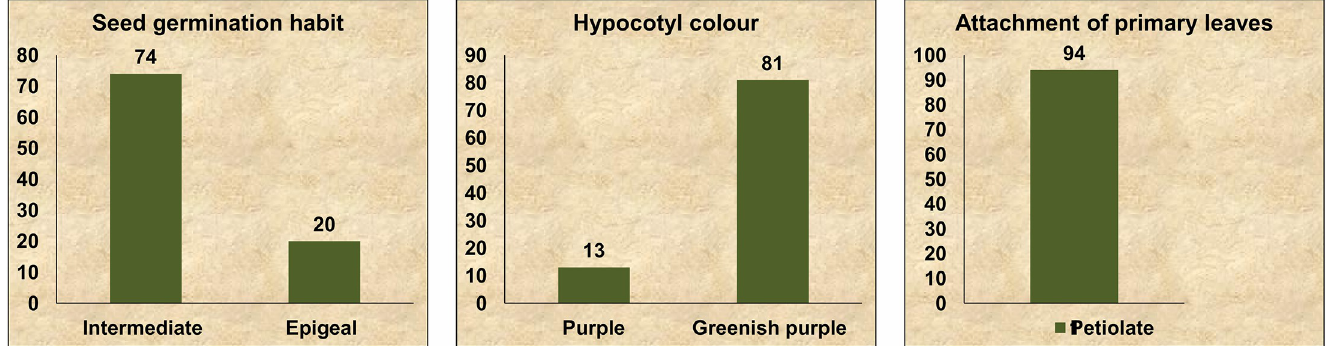
Fig 3. Variation in qualitative traits at germination stage among 94 accessions of V . stipulacea .